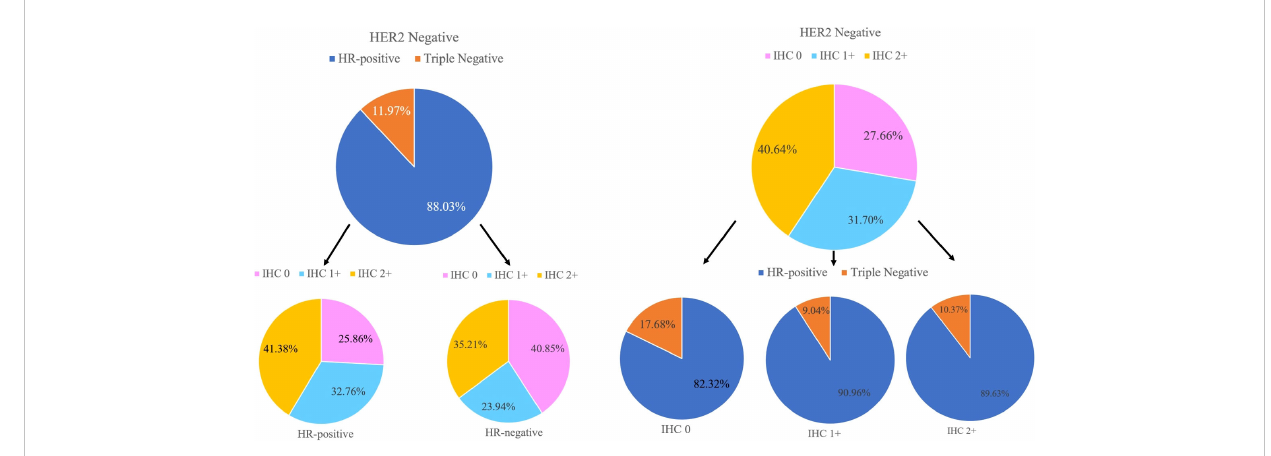
FIGURE 4 Hormone receptor (HR) status, HER2-low status, and IHC scores distributions within the HER2-negative